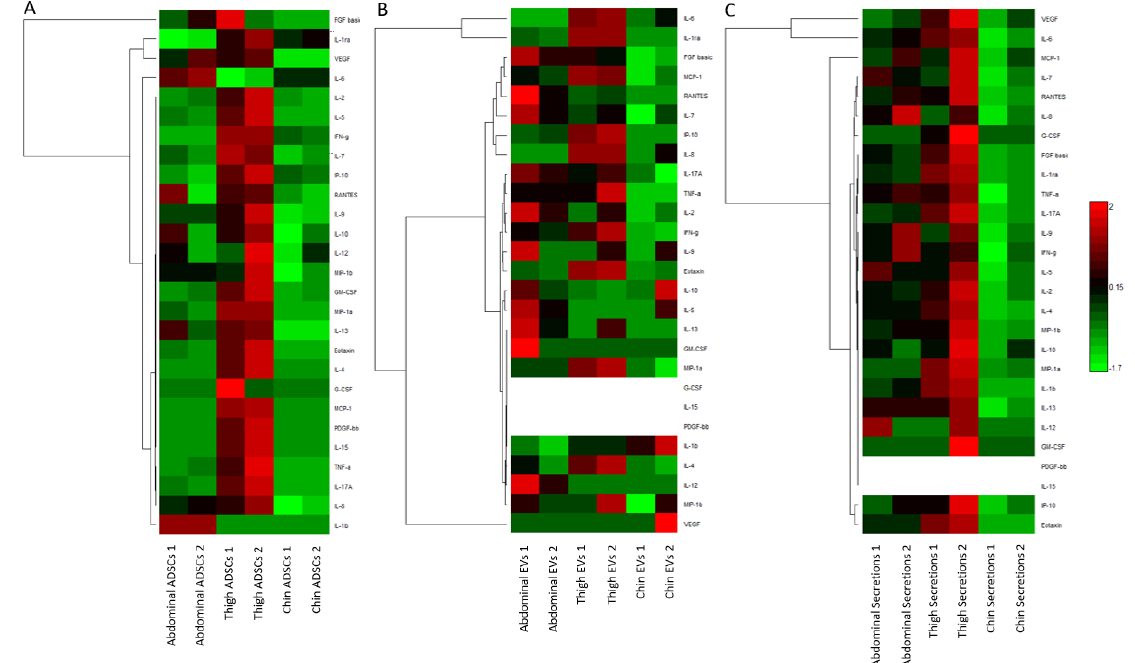
Figure 3. Bioplex quantified cytokines from ( A ) ADSCs derived from abdomen, thigh, and chin; ( B ) EVs produced from ADSCs derived from abdomen, thigh, and chin; ( C ) secretions produced from ADSCs derived from abdomen, thigh, and chin isolations. Log 10 scale where red is relatively high, green is relatively low, and white represents no values as cytokines were below the level of